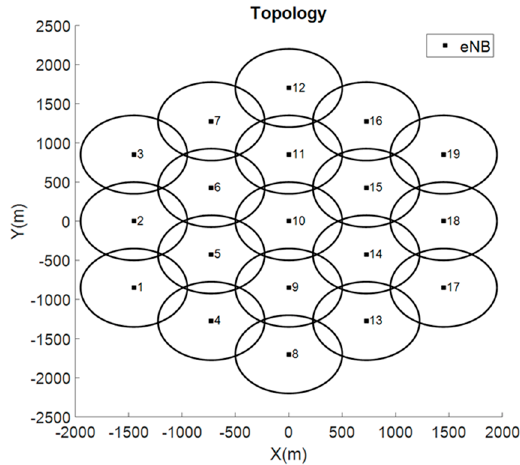
Figure 3. Network topology considered in the simulation. Table 1. Simulation parameters.